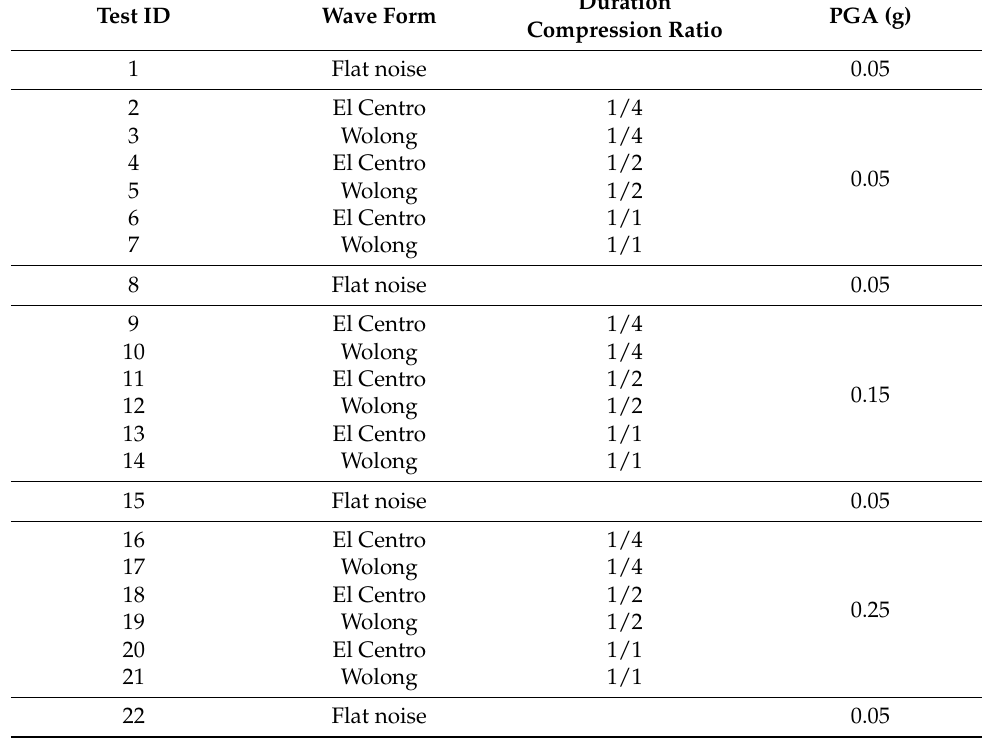
Table 2. Experimental loading